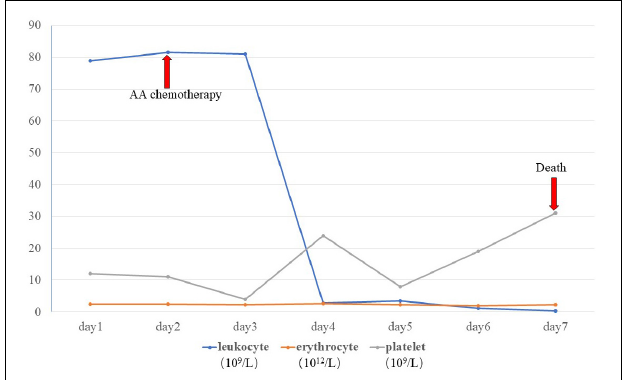
FIGURE 3 | Blood cell counts during